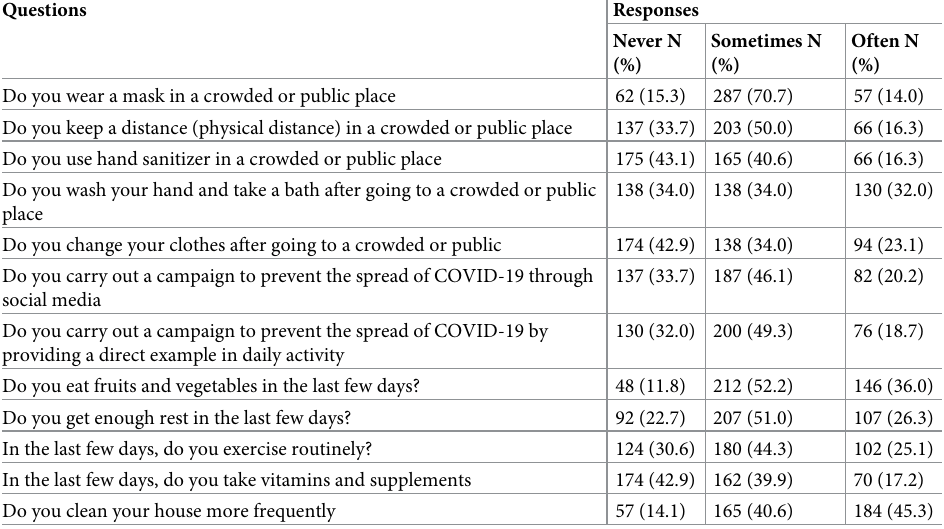
Table 4. Response to practice questions among preparatory school students at Mizan-Aman town, 2021 (n =